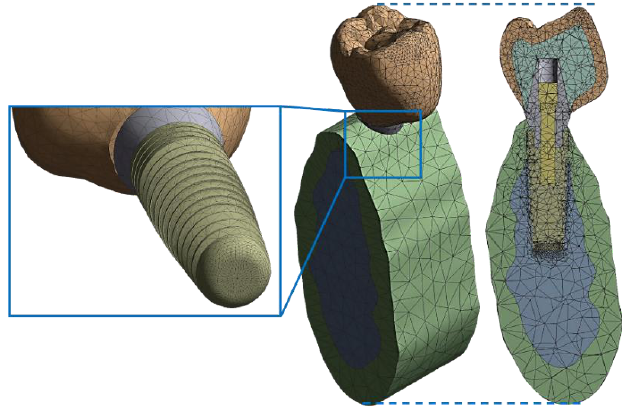
Figure 16. Finite element mesh. Left: detailed view of mesh at the apex. Center: perspective view. Right: cross-sectional view. Adapted from [20].